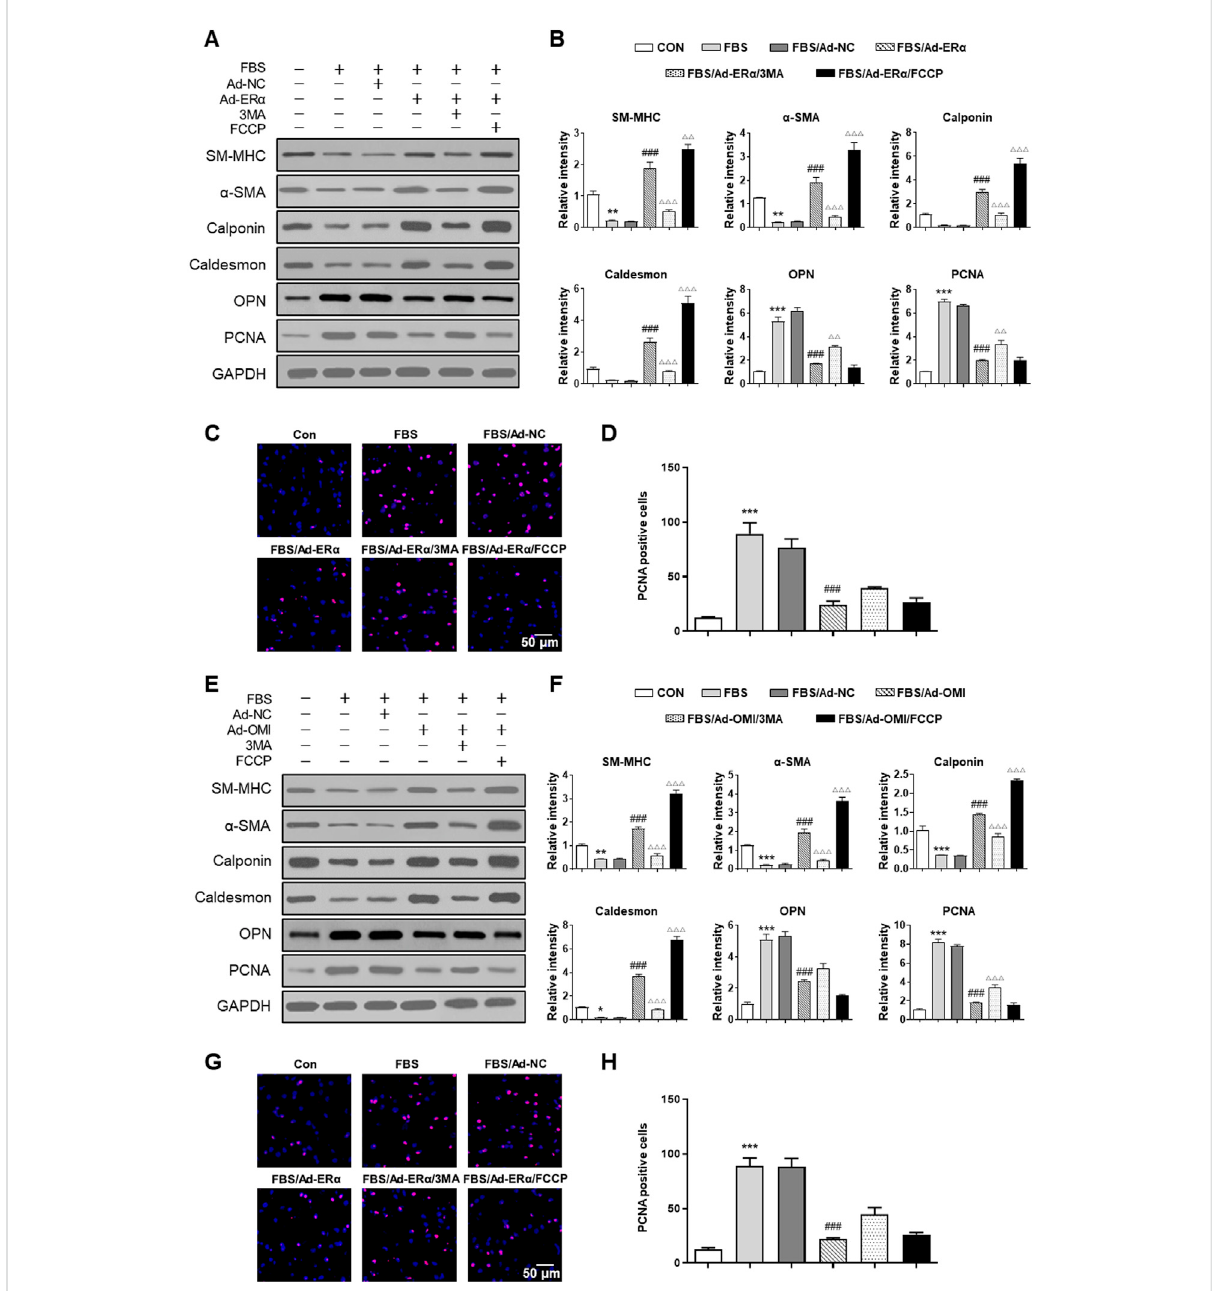
FIGURE 6 ER α -NRF1-OMI regulates proliferation of VSMCs via mitophagy. (A – D) , Western blot analysis of SM-MHC, α -SMA, calponin, caldesmon, OPN and PCNAprotein (A,B) andEdUincorporationassay (C,D) inA7r5cellstreatedwithorwithoutFBSandtransfectedwithAdenovirusesexpressingER α . (E – H) WesternblotanalysisofSM-MHC, α -SMA,calponin,caldesmon,OPNandPCNAprotein (E,F) andEdUincorporationassay (G,H) inA7r5cellstreatedwith orwithoutFBSandtransfectedwithAdenovirusesexpressingOMI.3MAandFCCPwereusedasmitophagyinhibitorandactivator,respectively.* p